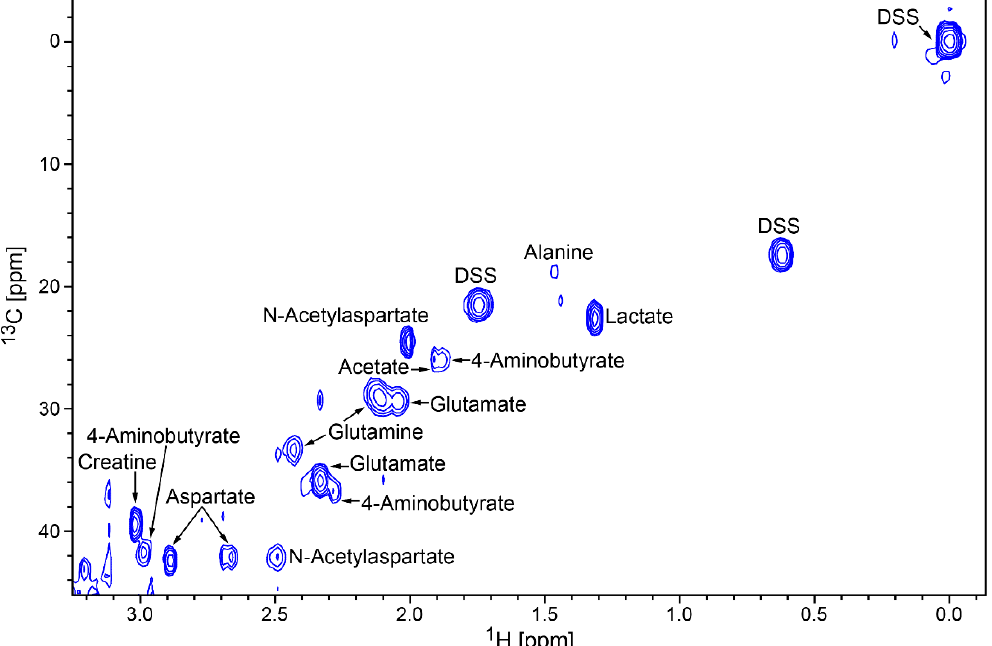
Table 1. Chemical shifts and multiplicities of 1 H NMR signals assigned to compounds in extracts of synaptosomes from control animals.